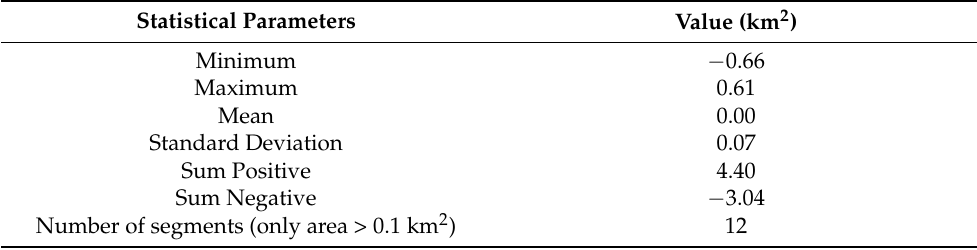
Table 2. Statistical parameters of